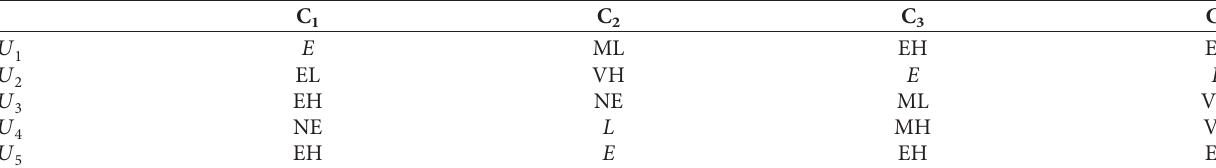
Table 2: The evaluated linguistic values of decision maker DM